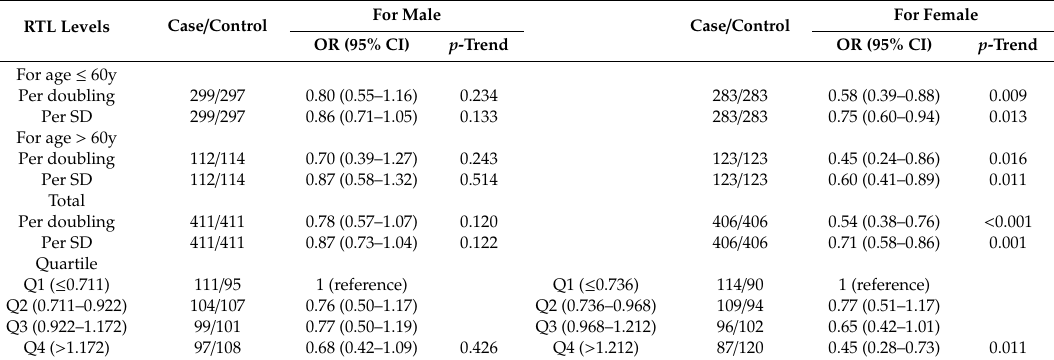
Table A1. OR (95% CI) for hearing loss by RTL levels stratified by sex and